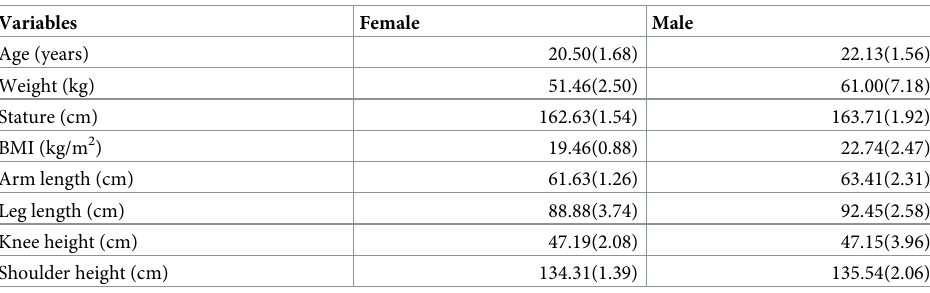
Table 1. Anthropometrics of the